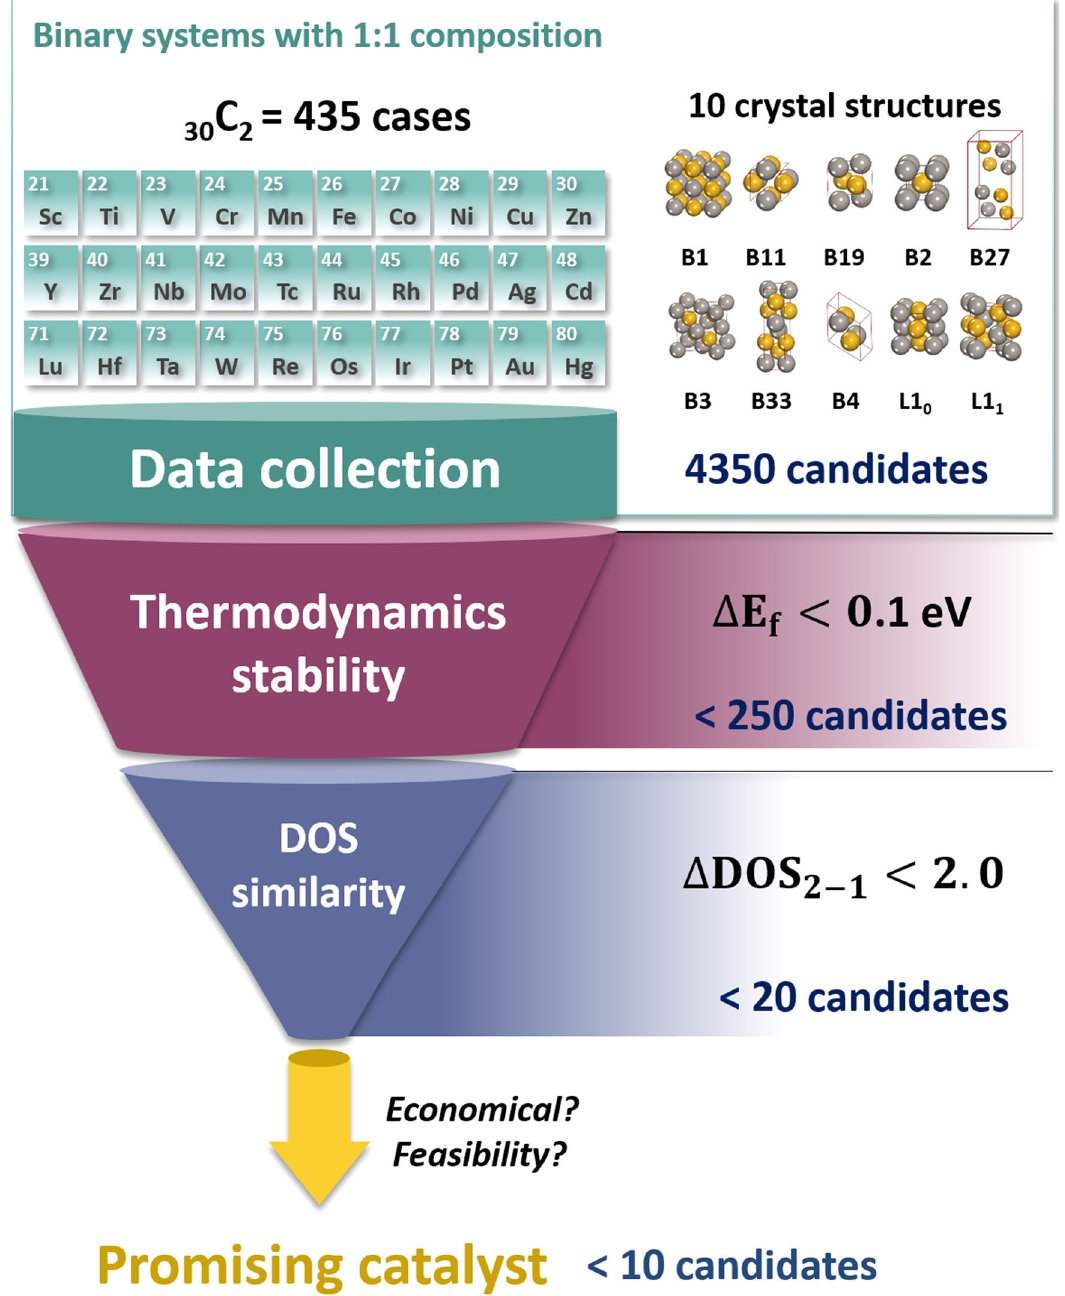
Fig. 1 High-throughput screening protocol for the discovery of bimetallic catalysts. There are three screening steps to identify catalyst candidates from 4350 candidates. The top (cyan color) section indicates the fi rst step showing 30 elements and 10 crystal structures to collect binary alloys with a 1:1 composition. The middle (magenta color) and bottom (violet color) sections indicate the second and the last steps relevant to the thermodynamic stability and the DOS similarity, lattice parameters for the alloyed samples are presented in Supplementary Table 1. In addition, we performed Rietveld re fi nements of the XRD patterns (Supplementary Figure 1). The synthesized NPs clearly have cubic-based structures as predicted by our DFT calculations, although in the Ni-Pt samples a small amount of non-alloyed Pt (pure Pt) coexists with alloyed Ni 72 Pt 28 . As we used the synthesized Ni-Pt samples themselves when measuring their catalytic performance, we used the ICP composi- tion (Ni 61 Pt 39 ).